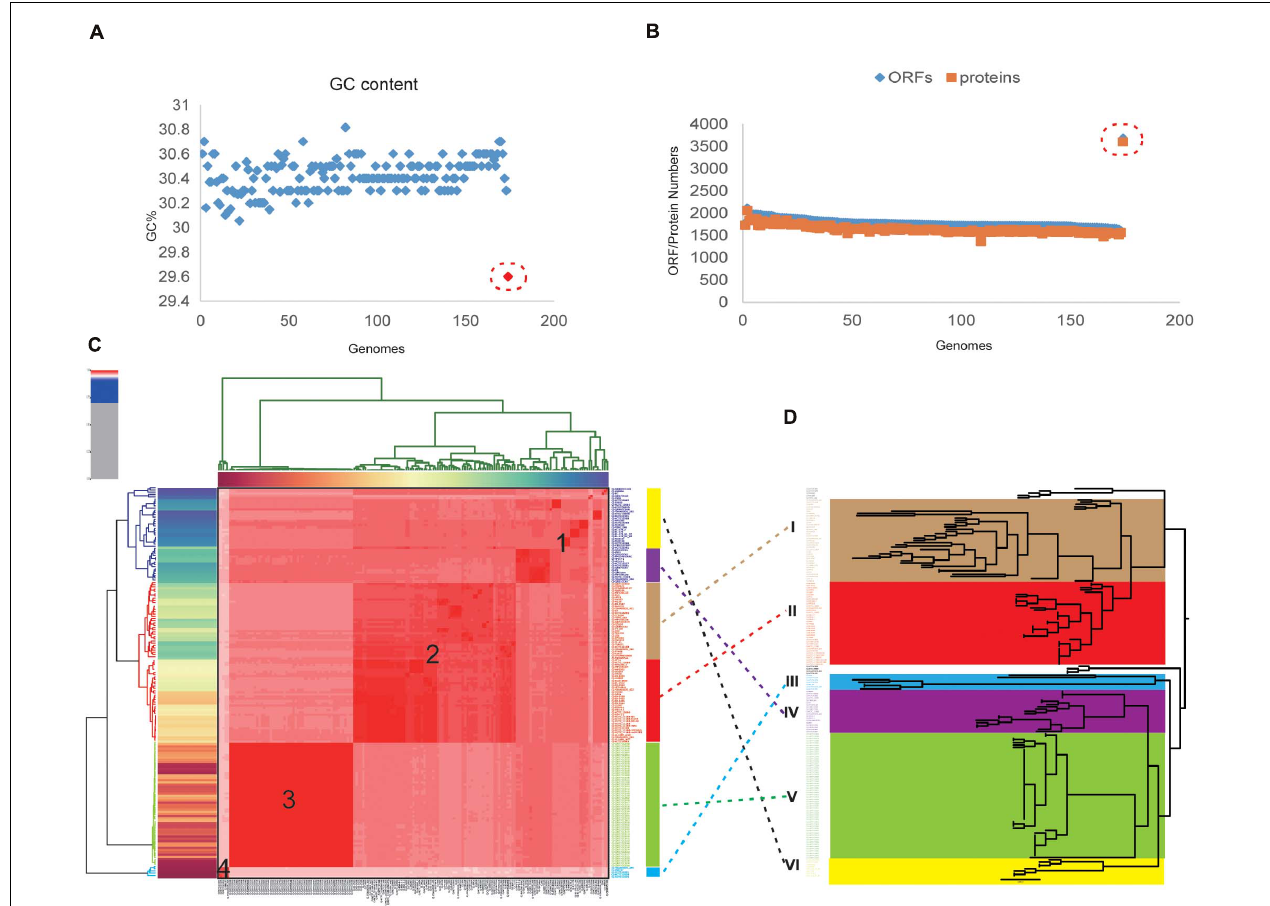
FIGURE 1 | Taxonomic classification of Campylobacter jejuni based on comparison at the whole-genome level. (A) The GC content of 174 original complete genomes in NCBI. Strain 414 is highlighted with the red circle , which is obviously far away from the other strains. (B) Numbers of genes and open reading frames (ORFs) of 174 complete genomes. Strain 414 is highlighted with the red circle . (C) Phylogenetic tree based on BLAST all vs. all of the 173 C. jejuni strains, which could be divided into four groups (numbers 1 , 2 , 3 , 4 marked in the red area ). The vertical rectangular boxes correspond to the relevant clades in the core genome tree (the different colors of the boxes match the clades on the right , e.g., the red box corresponds to clade III). (D) Core genome tree based on the 911 core genes of 173 strains. Different colors represent the diverse